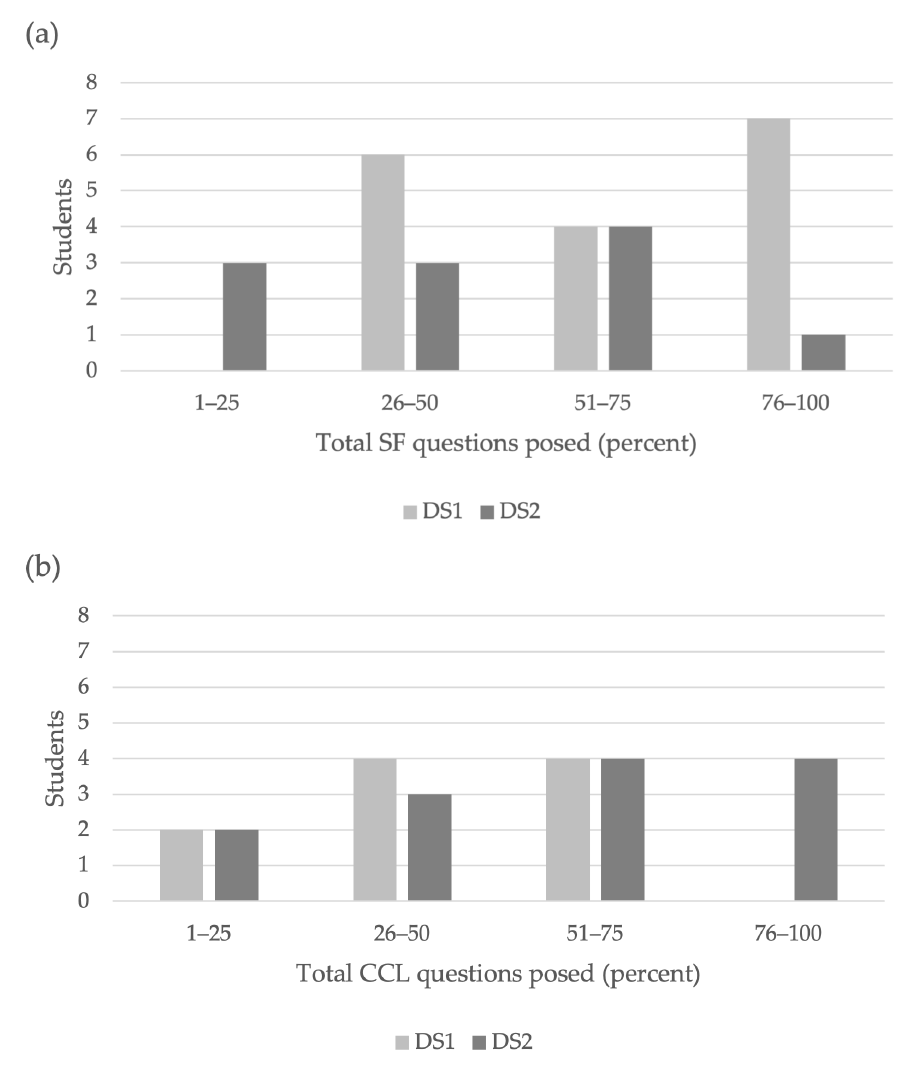
Figure 4. Numbers of students and percentages of their total questions that were ( a ) SF considerations or ( b ) CCL considerations in Design Sprint 1 (DS1), which took place during the second week of class, and Design Sprint 2 (DS2), which took place during the 14th week of class. Both design sprints had greater than 85% class participation. Sixteen students completed the class.